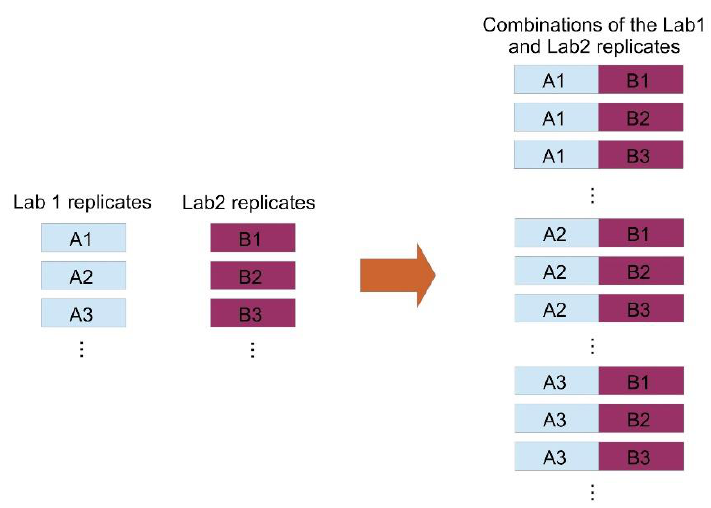
iscreatedby combiningeach measure from Lab 1 (A) with each measure from Lab 2 Figure 1. Method of combination of replicates from the twolaboratories. The set of measures iscre- atedby combiningeach measure from Lab 1 (A) with each measure from Lab 2 (B).